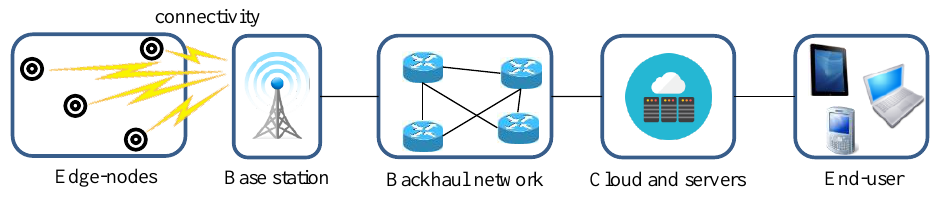
Figure 2. LP-WAN network architecture.